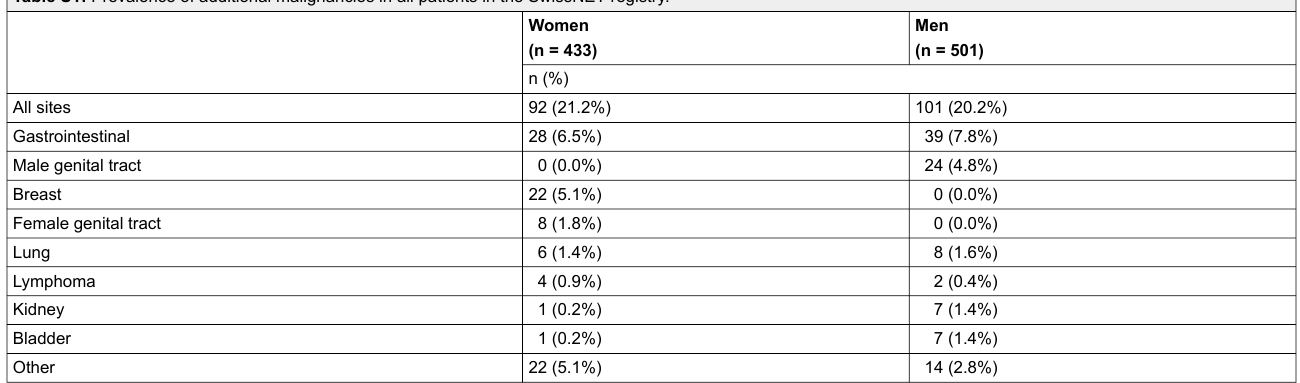
Table S1: Prevalence of additional malignancies in all patients in the SwissNET